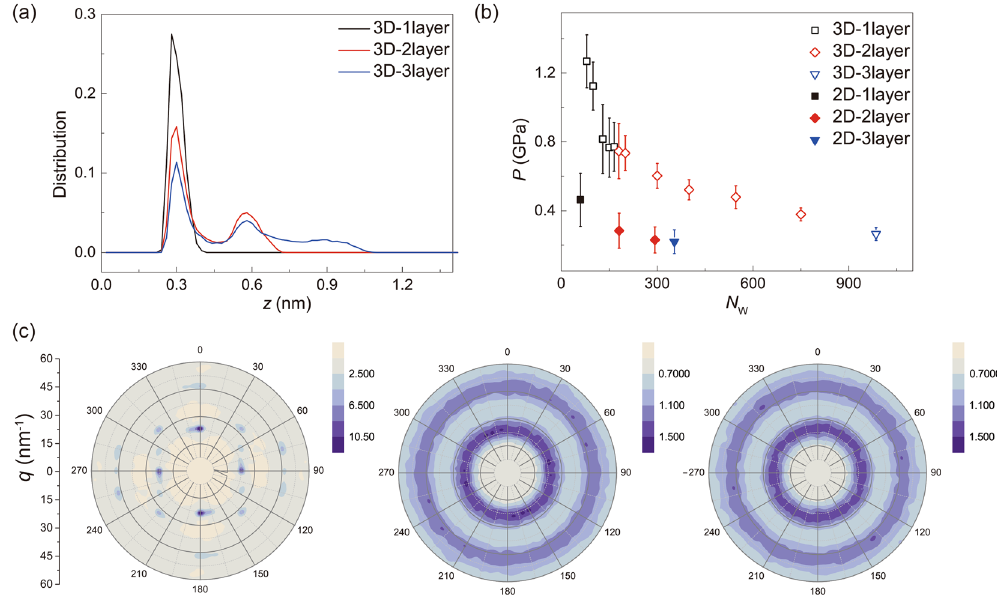
Figure 2. ( a ) Density profiles at 300 K, measured along the z direction of encapsulated water in the 3D model, with N W = 115, 546 and 986 for 1, 2 and 3 layers. ( b ) Pressure in the water condensation plotted as a function of the number of water molecules at T = 300 K. ( c ) In-plane structure factors of nanoconfined mono-, bi- and tri-layer water with N W = 115, 546, 986 at T = 300 K. The error bars are obtained from the thermodynamic fluctuations measured in MD simulations. Here the wave vector q is represented as its amplitude q and orientation in the polar plots. The color denotes the amplitude of structure factor S ( q